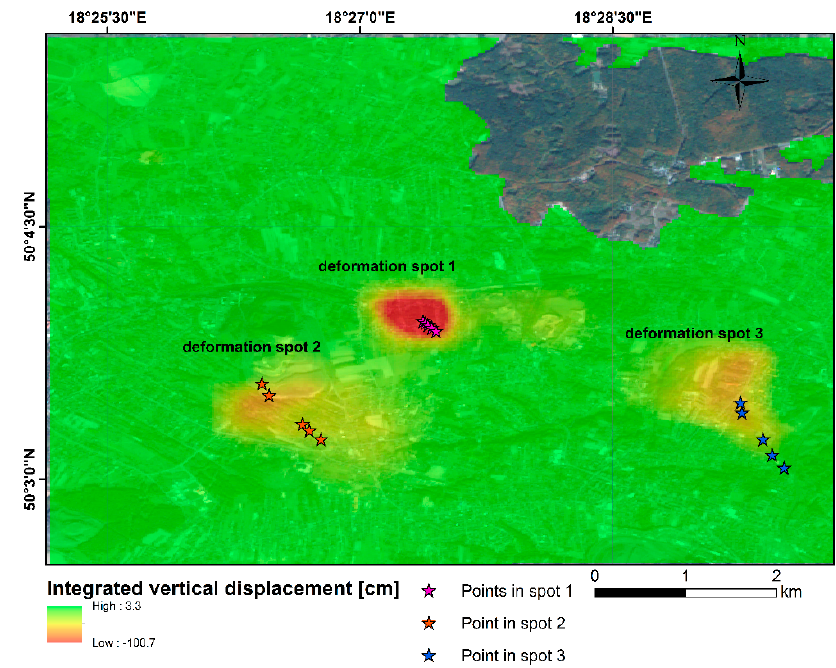
Figure 6. The final vertical displacement map over the Rydułtowy mine between 1 January 2017 and 8 October 2018. The stars refer to extracted time-series deformation in particular deformation spots and are presented in Figure 9.